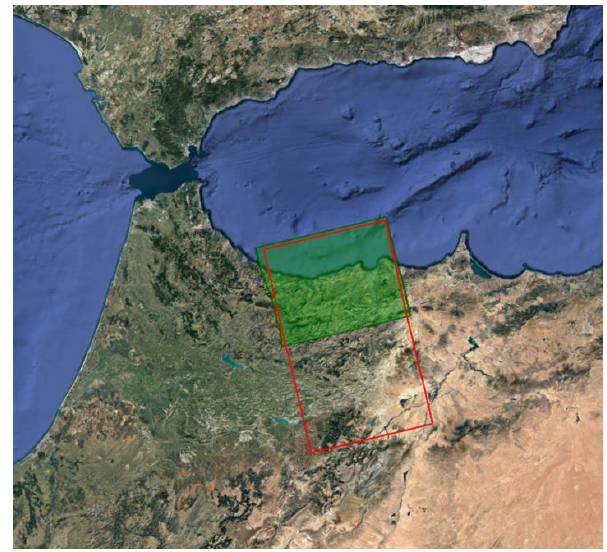
Figure 15. Example for scene coverage verification after data take acquisition, visualized in Google Earth. The red polygon indicates the requested scene, whereas the green polygon shows the acquired scene. In this case, a considerable part of the data take is not available, as the downlink was affected by severe weather conditions.